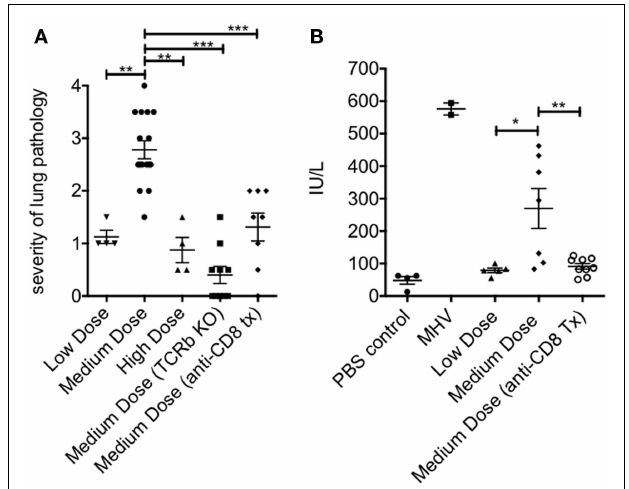
FIGURE 4 | Increased pathology in the lung and liver during medium dose LCMV clone 13 infection . (A) The severity of the lung pathology was scored using our established histology scale (see Materials and Methods). The lungs of mice infected with LCMV clone 13 medium dose i.v. had significantly more severe lung pathology than low dose or high dose-infected mice at day 13 post infection.This pathology was abrogated by anti-CD8 mAb treatment or by infectingTCR β KO mice (** p = 0.003, *** p < 0.001; n = 4–9 mice/group) (B) Severity of liver pathology was assessed by measuring the levels of the liver enzyme ALT at day 13 post infection (see Materials and Methods). ALT levels were significantly increased in medium dose-infected mice as compared to low dose. Treatment with anti-CD8 at the time of infection with medium dose prevented this increase in ALT levels. Positive control for this ALT assay is day 13 mice infected with mouse hepatitis virus (MHV) ( N = 2) (* p = 0.02, ** p = 0.008; n = 6–10 mice/group).These data represent two separate experiments pooled.